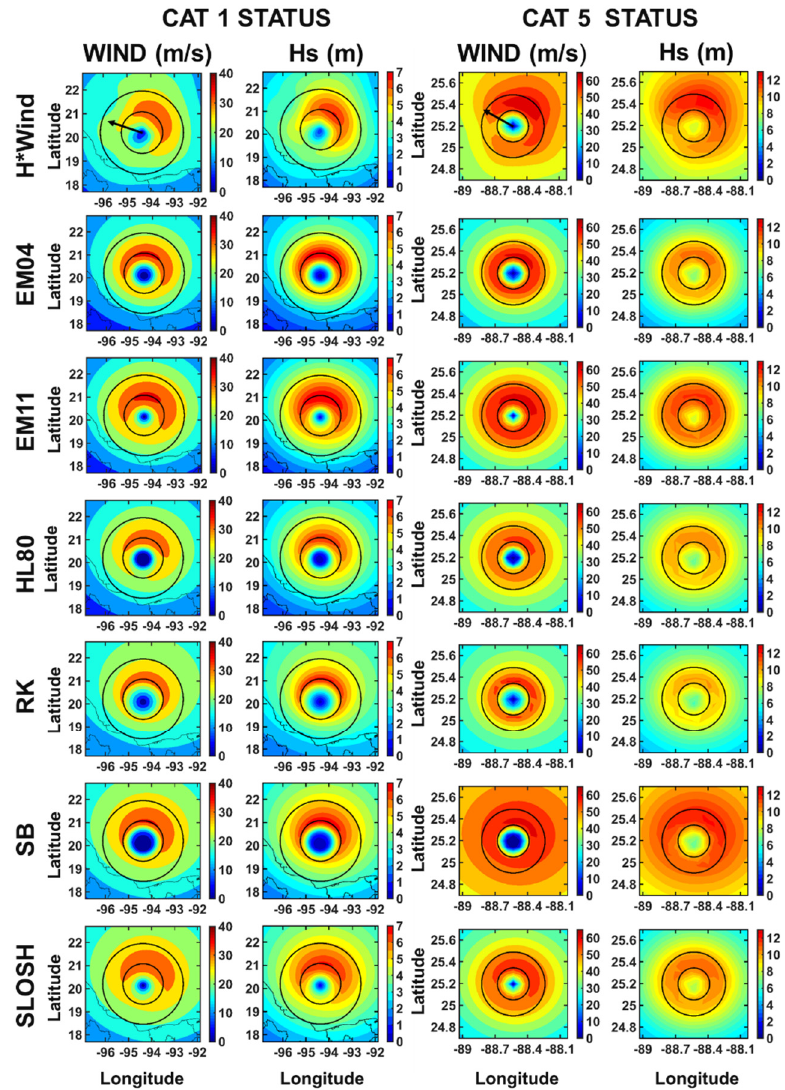
Figure 6. H*Wind and parametric steady-state wind and significant wave heights ( Hs ) fields associated for static situation corresponding to Dean as category 1 at 20070822T0730 (left panels) and Rita as category 5 at 20050922T1330 (right panels). Circles correspond to the distance of R mw and 2 × R mw . The black arrow shows the TC direction.